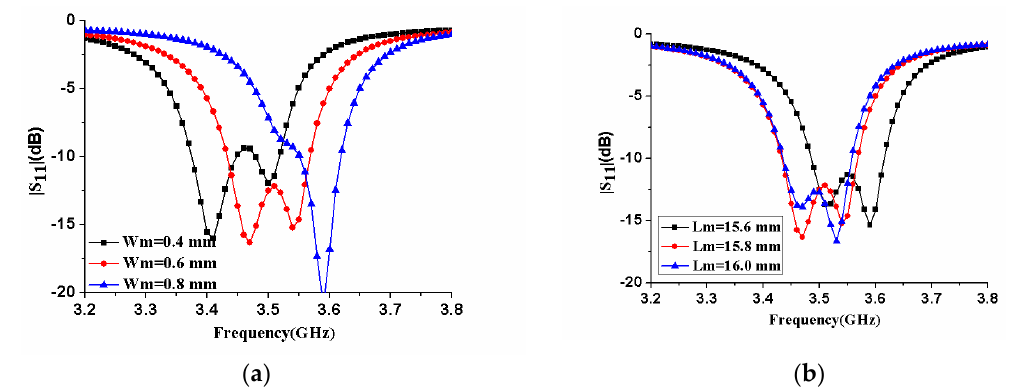
Figure 6. |S 11 | of the antenna element with different sizes of DSPSL ( a ) different width w m ; ( b ) different length L m .